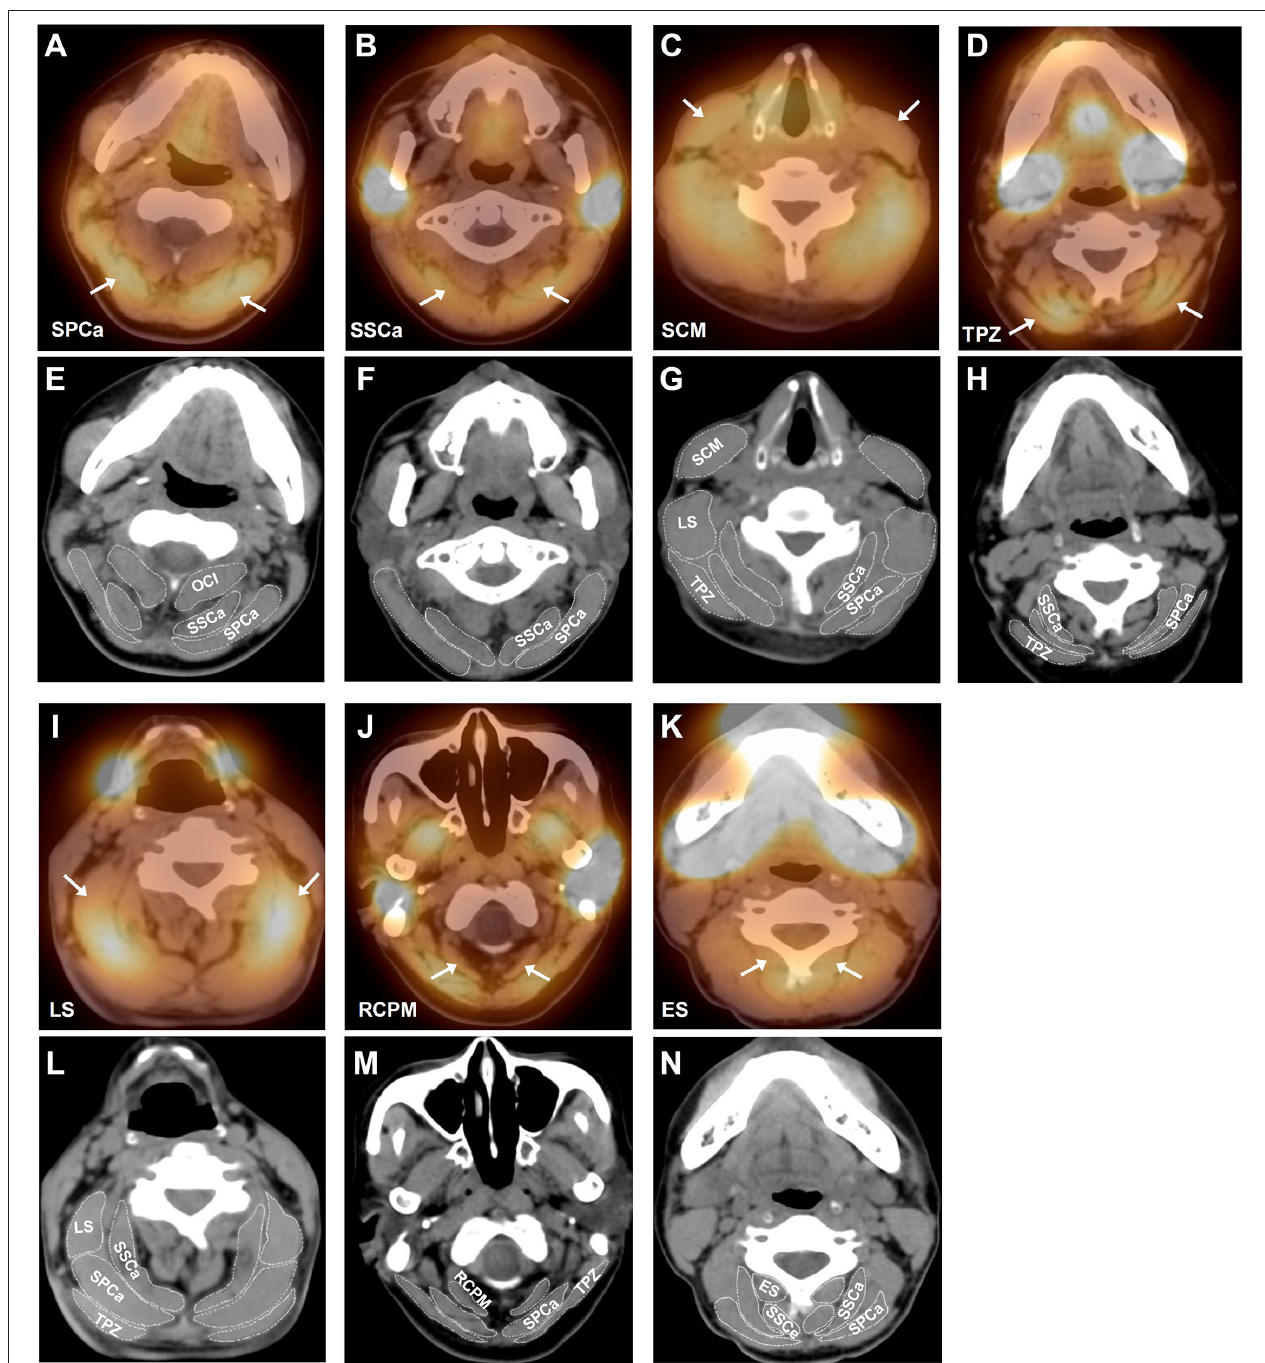
FIGURE 2 | Representative SPECT/CT images of different activated cervical muscles in patients with RCD. (A) Bilateral activation of splenius capitis (SPCa) indicated by the white arrows; (B) bilateral activation of semispinalis capitis (SSCa) indicated by the white arrows; (C) bilateral activation of sternocleidomastoid muscle (SCM) indicated by the white arrows; (D) bilateral activation of trapezius (TPZ) indicated by the white arrows; (I) bilateral activation of levator scapulae (LS) indicated by the white arrows; (J) bilateral activation of rectus capitis posterior major (RCPM) indicated by the white arrows; and (K) bilateral activation of erector spinae (ES) indicated by the white arrows. To demonstrate the anatomy of cervical muscles more clearly, we put the CT images of the same level below each SPECT image and outlined the boundaries of related muscles. (E–H) are CT images of (A–D) respectively, and (L–N) are CT images of (I–K) respectively. OCI, obliquus capitis inferior; SSCe, semispinalis